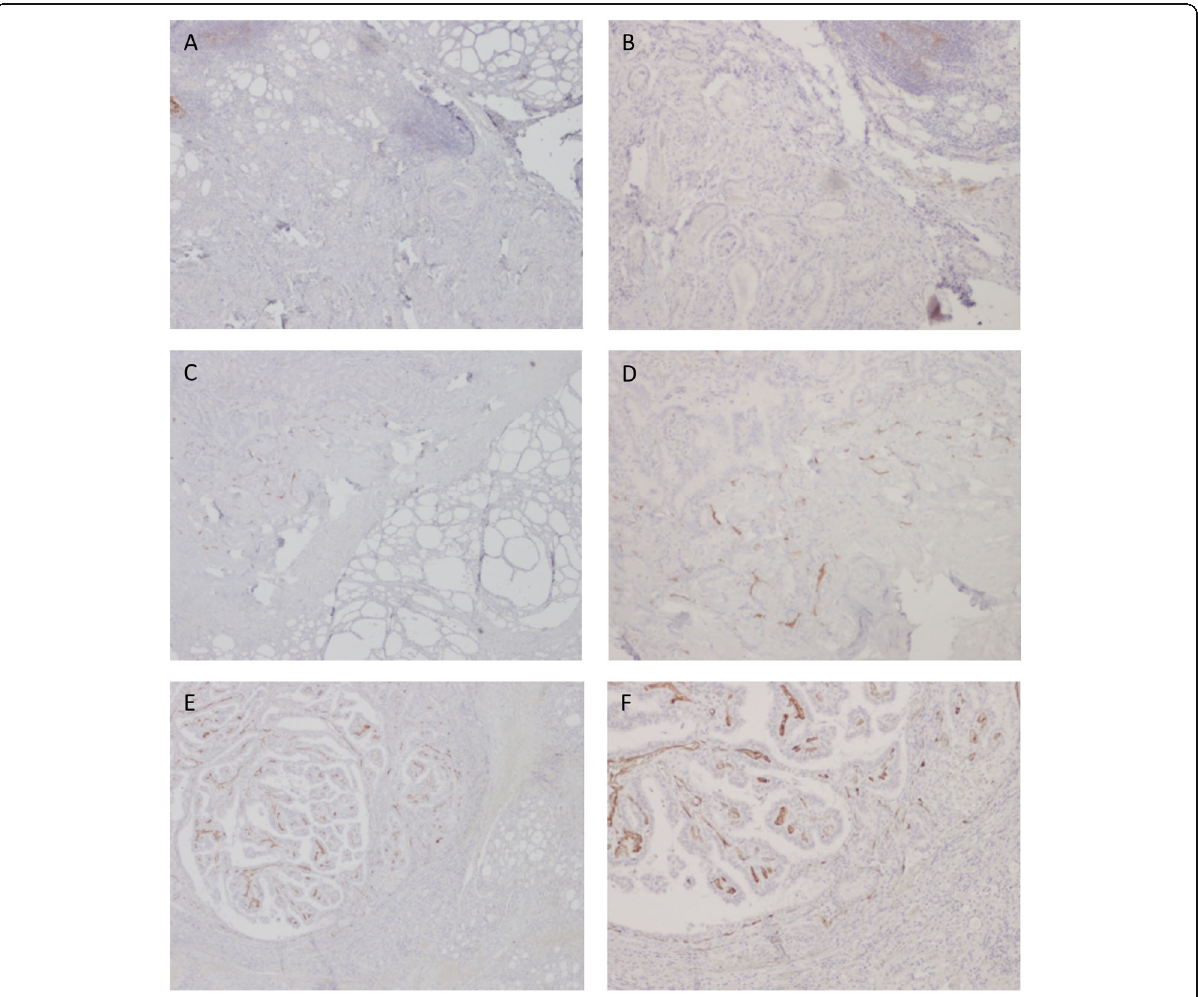
Fig. 1 Different patterns of PSMA immunoreactivity in papillary thyroid cancer. a , b Faint staining is observed in a few endothelial cells, quantified as 1% (PSMA, × 4 and × 20). c , d Moderate staining is seen in some endothelial cells (PSMA, × 4 and × 20). e , f Strong stain is present in almost all endothelial cells (PSMA, 4x and